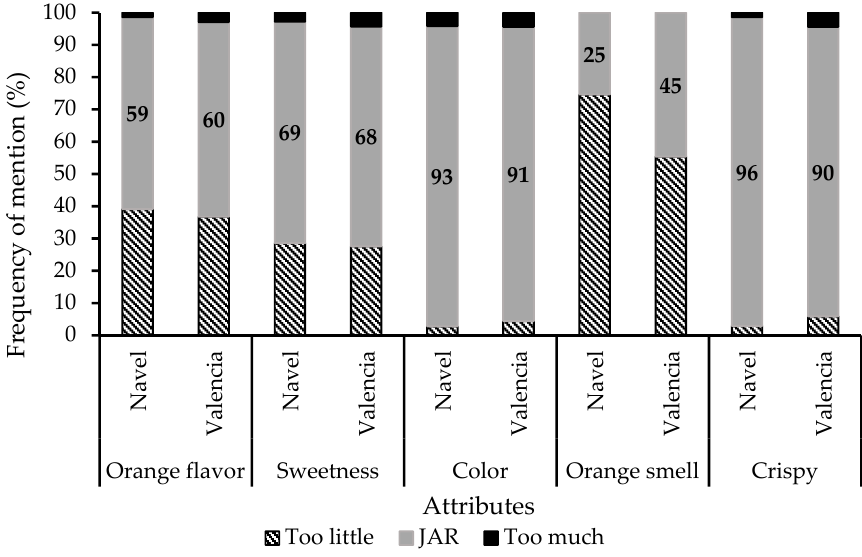
Figure 6. Sensory evaluation study with consumers ( n = 75) of the biscuits with orange pomace using CATA + JAR. Frequency distribution in percentage for just-about-right scores for each dimension (too little, JAR, too much) and each attribute. The number represents the percentage of consumers who selected an attribute as “just about right”.